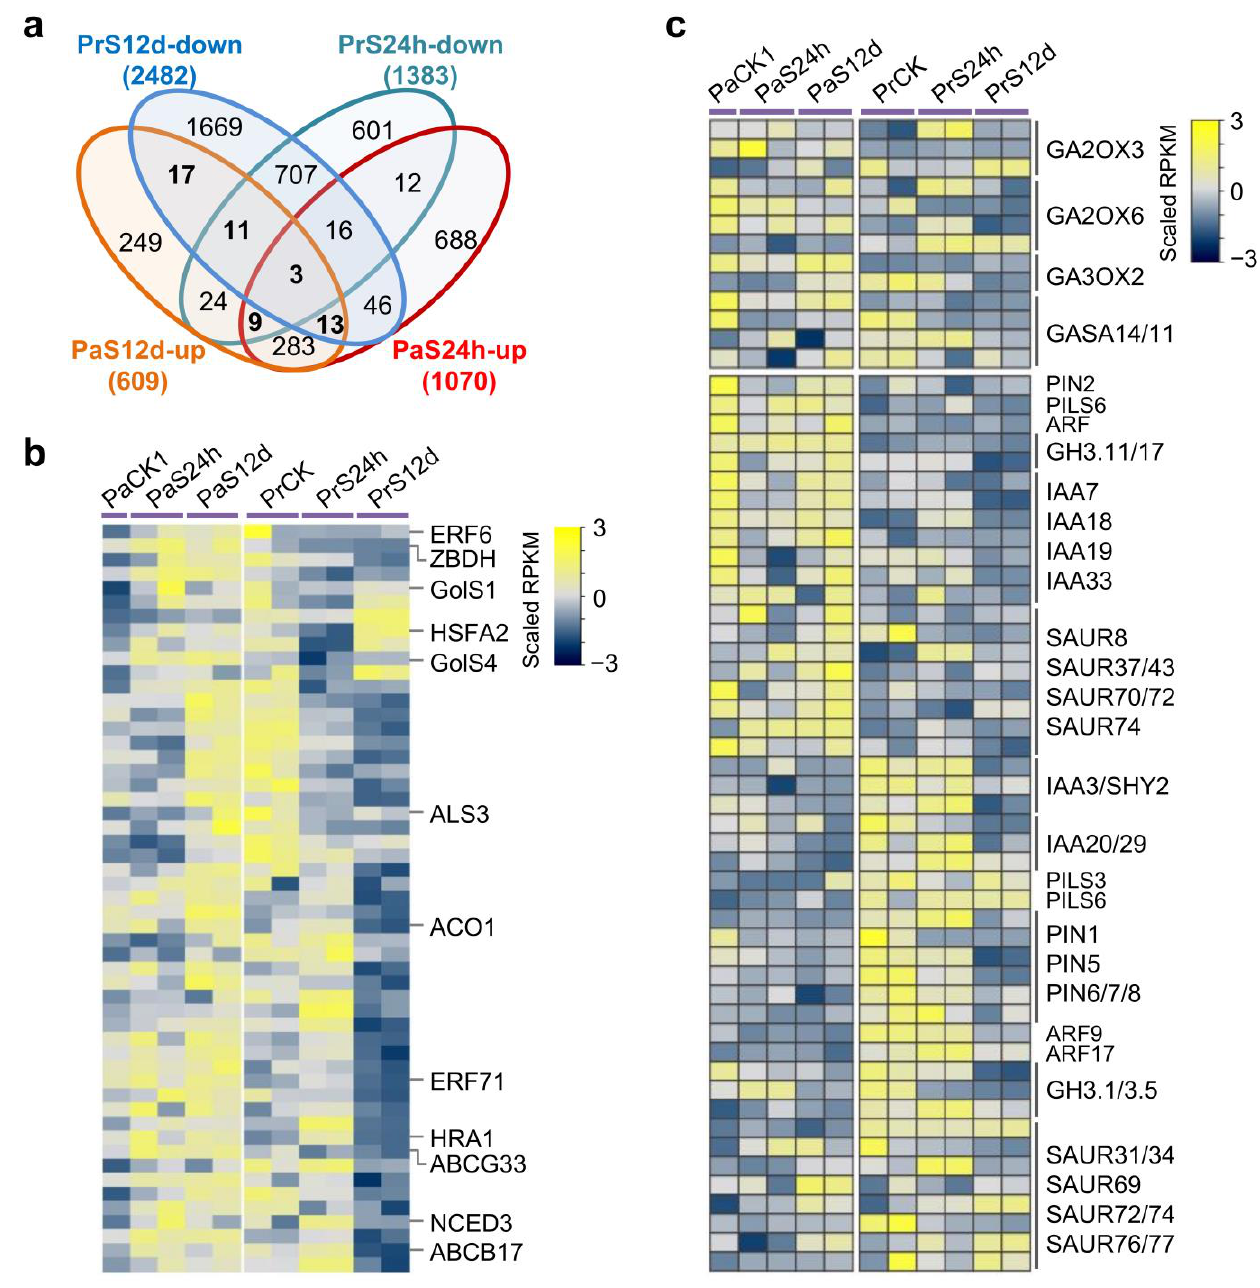
Figure 6. Identification of the expression pattern divergent genes in P. alba and P. russkii roots under salt stress. ( a ) Venn diagrams showing the overlapping of the up-regulated genes in P. alba and downregulated genes in P. russkii under salt stress. ( b ) Heatmap showing the genes that the expression patterns were reversed in the two Populus under salt stress. ( c ) Heatmap showing the expression of the genes involved in GA or auxin signaling pathways in the two Populus under salt stress.